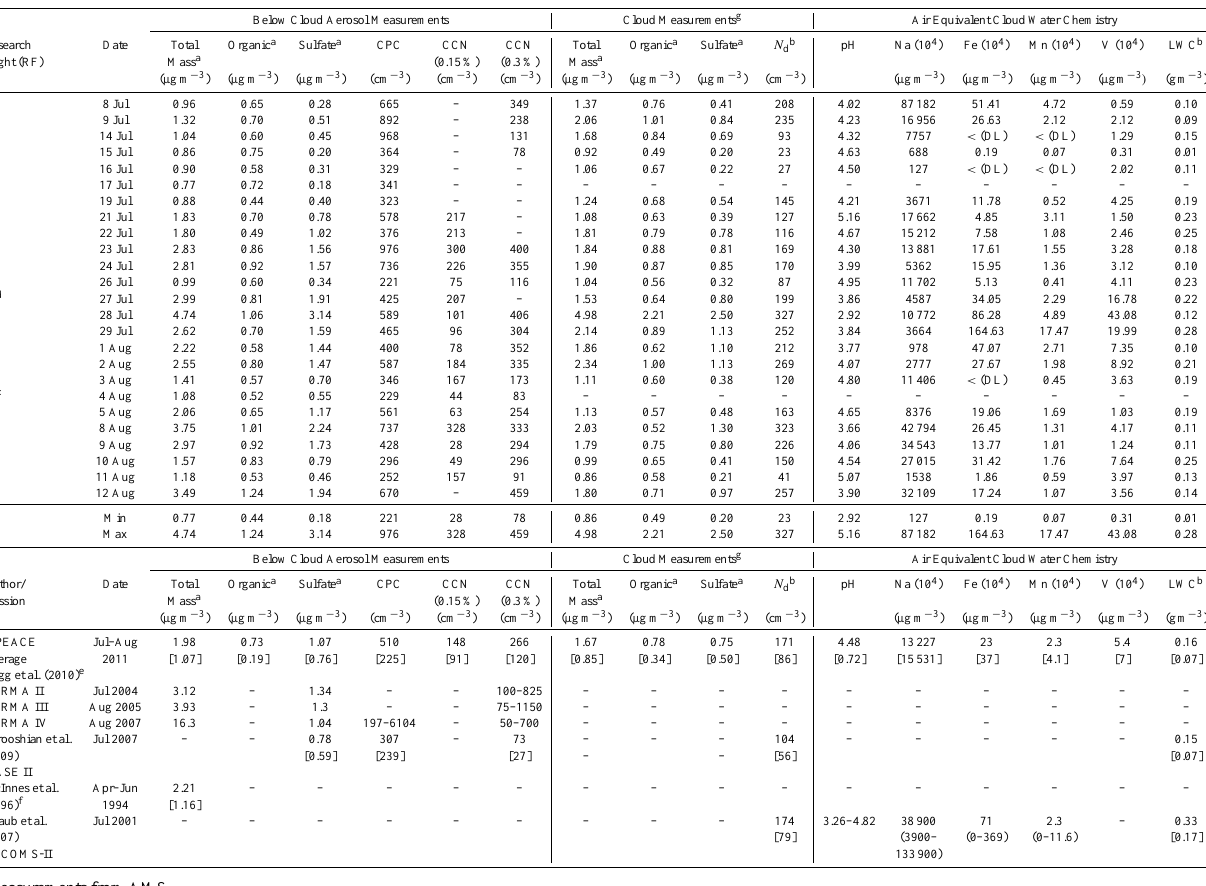
Table 3. Summary of average aerosol and cloud properties over the course of the E-PEACE campaign. Bottom table summarizes key aerosol properties from previous studies of marine aerosol and cloud droplets off the coast of Central California. Values in brackets represent standard deviations of the average. Values in parenthesis list the range of measurements. Values below detection limit (DL) are